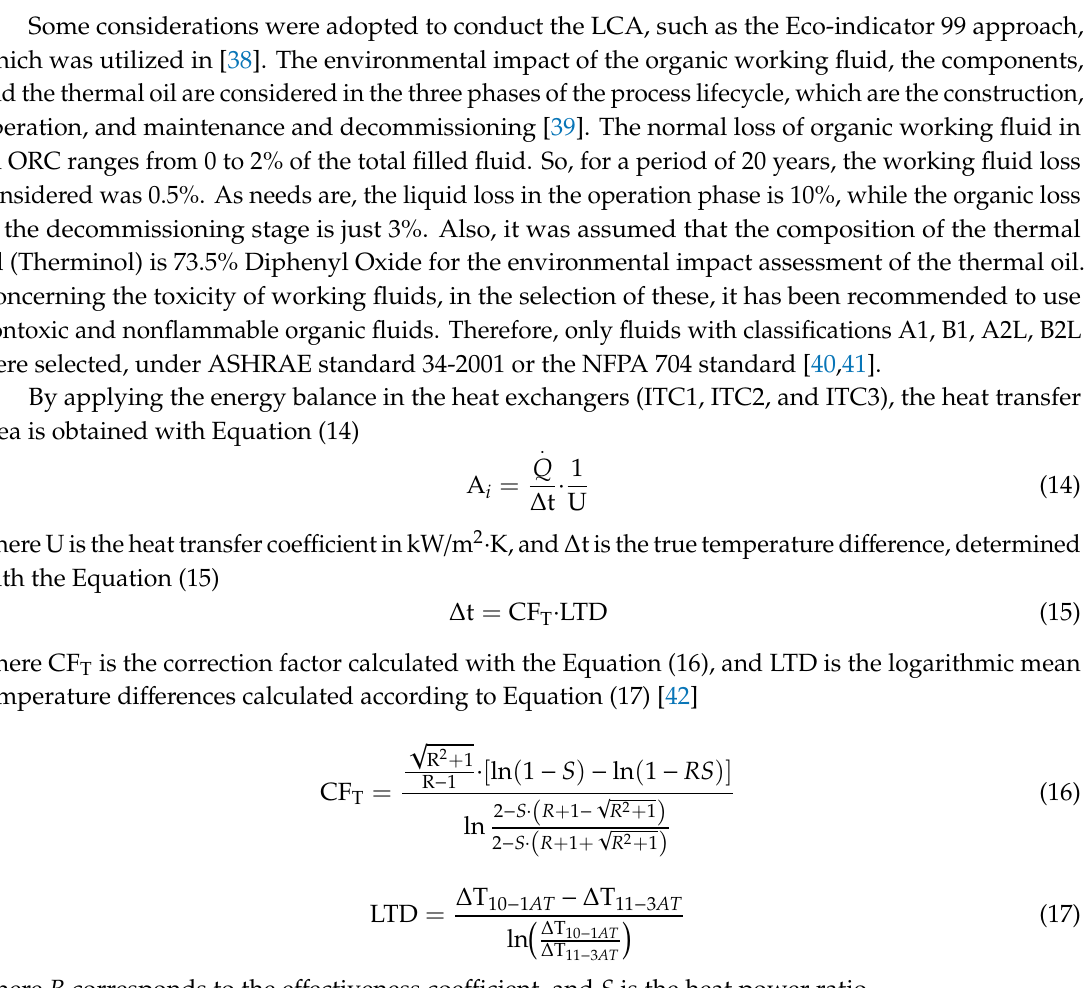
Figure 3. Life cycle assessment system boundary diagram.